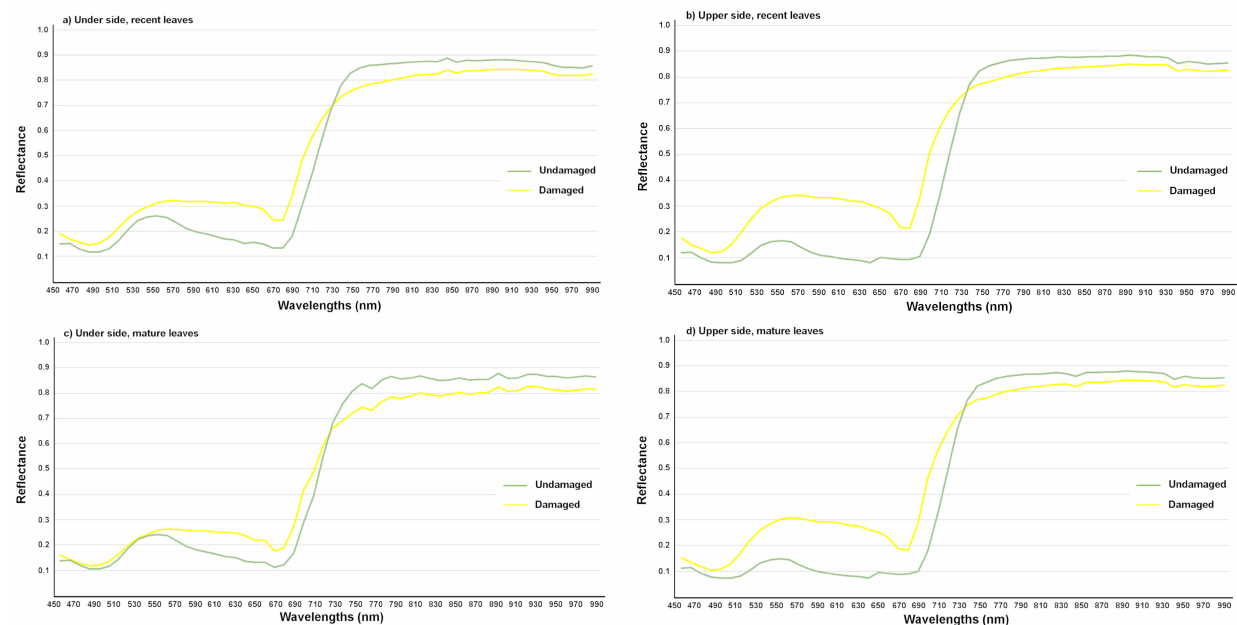
Figure 4. Mean spectra of healthy and damaged regions extracted from sets G1 (undamaged) and G2 (damaged) at each age and on ( a ) under side, recent leaves; ( b ) upper side recent leaves; ( c ) under side mature leaves, and ( d ) upper side mature